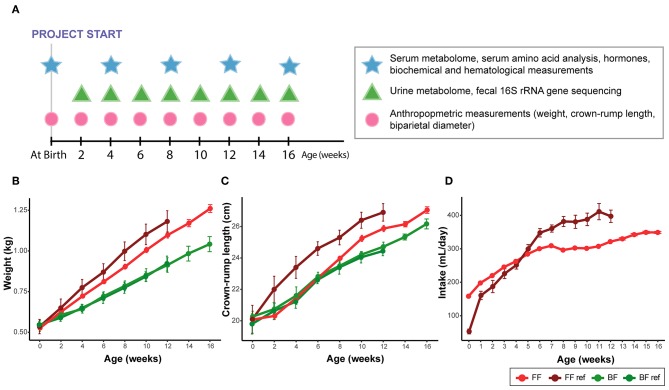
(A) Summary of sample collection times. (B) Weight, (C) crown-rump length, and (D) formula intake of infant monkeys from birth to age of 16 weeks. Data were collected from breast-fed (BF) and pooled among all formula-fed (FF) rhesus infants from the current study and from the previous work [BF ref, FF ref (14)]. The amount of milk obtained from the exclusively breast-fed rhesus monkeys could not be recorded. Data are presented as mean ± SEM.